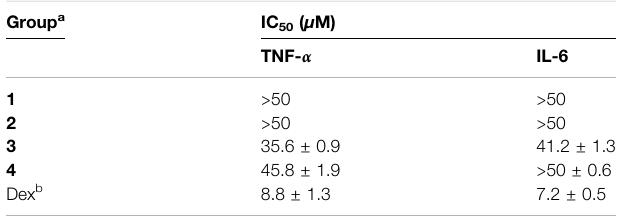
TABLE2| Inhibitoryactivityofcompounds1 – 4againstTNF- α andIL-6production in RAW 264.7 cells. Group a IC 50 ( μ